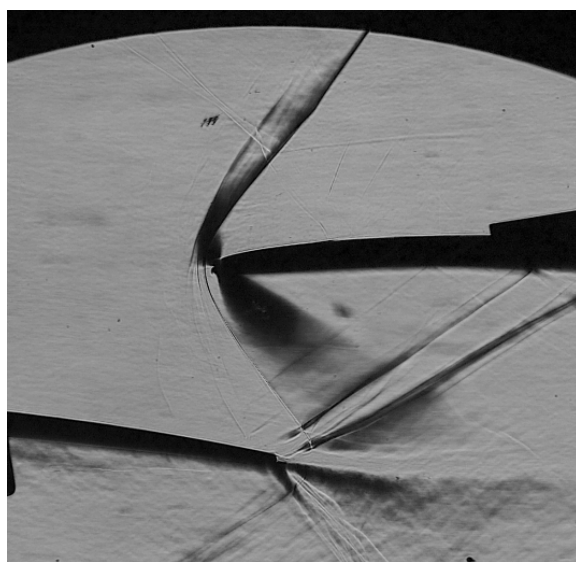
Figure 4. Started supersonic flow field.